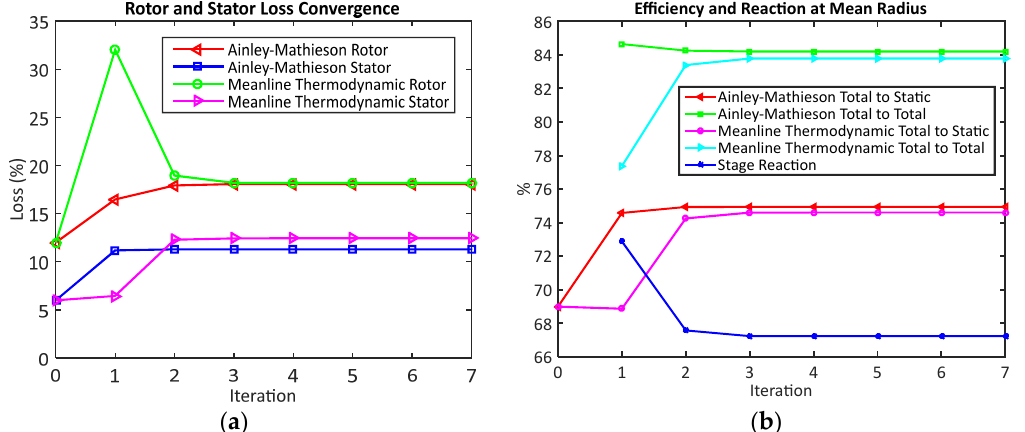
Figure 9. Convergence plots for Ainley-Mathieson and meanline thermodynamic ( a ) losses ( b ) efficiencies.